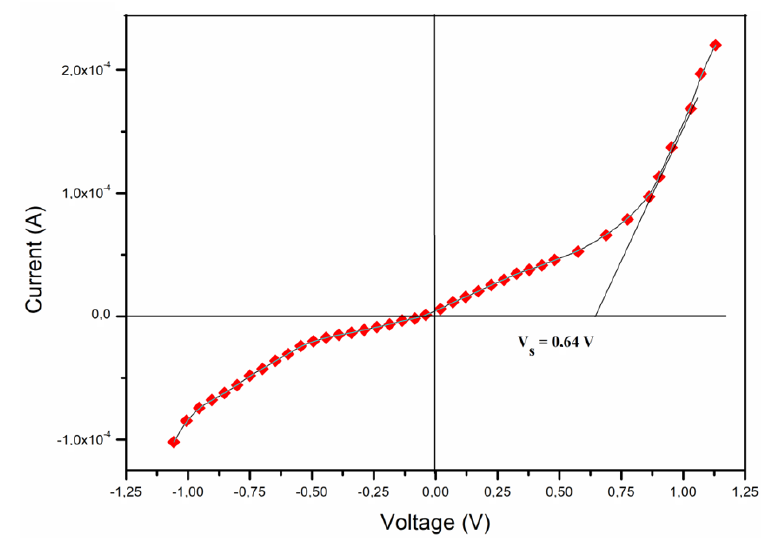
Figure 8. Current – voltage curves of ITO/complex ( 4 ). Figure 8. Current–voltage curves of ITO/complex ( 4